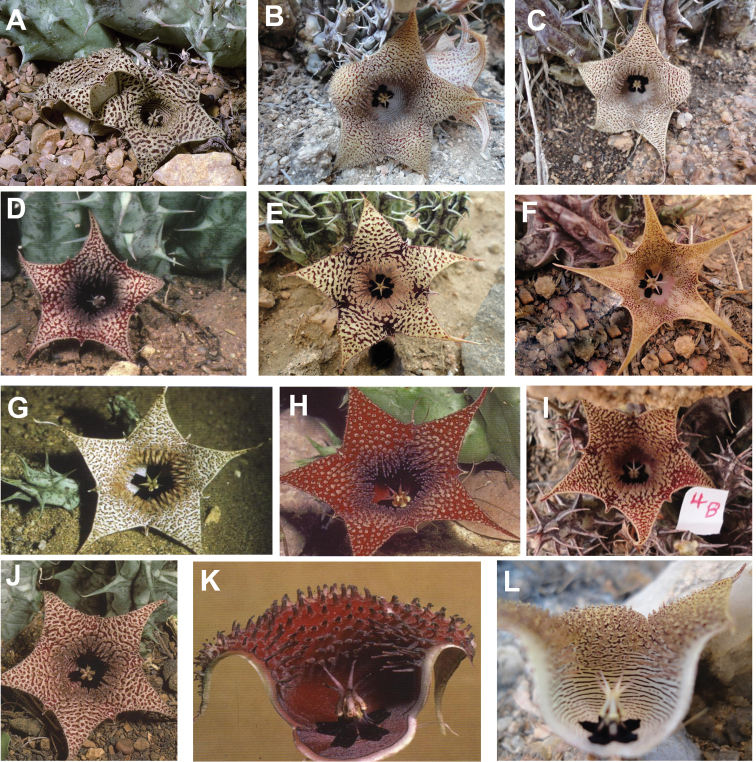
Ceropegia
lodarensis
var.
lodarensisA ex J Lavranos 1789, sub DP3604, Yemen, (H.
lodarensis, Type) BAlharbi S6B (H.
collenetteae) CAlharbi S9B (H.
collenetteae) D ex Collenette 549 sub DP6865, Jabal Al Sawdah, (H.
saudi-arabica, Type) EAlharbi S2B (H.
collenetteae) FAlharbi S18a (H.
collenetteae) GCollenette 2227, Al-Hadda, (H.
collenetteae) H ex Collenette 8232 sub DP8126, (H.
saudi-arabica) IAlharbi S4B (H.
collenetteae) J ex Collenette 1176 sub DP6868, Jabal Al Sawdah, (H.
collenetteae, Type) K maroon uniform colour of corolla tube in ex Collenette sub DP6594, Abha, (H.
saudi-arabica) L concentric broken maroon lines of corolla tube in Alharbi S6B (H.
collenetteae). (A) reproduced from Plowes (2014); (D, G, H, J, K) reproduced from Plowes (2012); (B, C, E, F, I, L) photo by the first author from Wadi Thee Gazal, Ash Shafa.